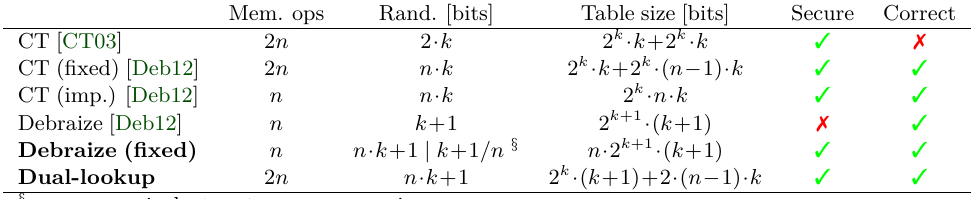
Figure 8: TVLA of our dual-lookup A2B for a pool of 100.000 measurements Table 2: Characteristics of the different table-based A2B conversions. Mem. ops Rand. [bits] Table size [bits] Secure